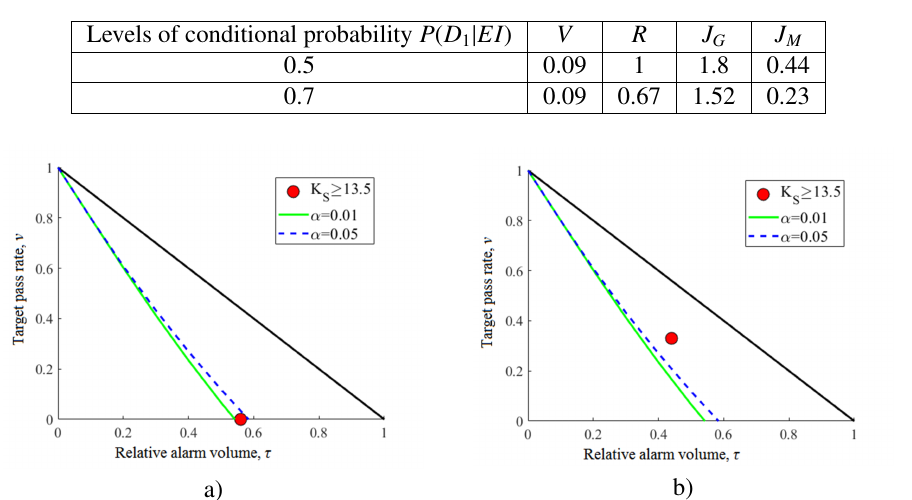
Table 4. The e ff ectiveness for the method of earthquakes prediction with K S ≥ 13 . 5 for chosen levels of the conditional probabilities P ( D 1 | EI ).